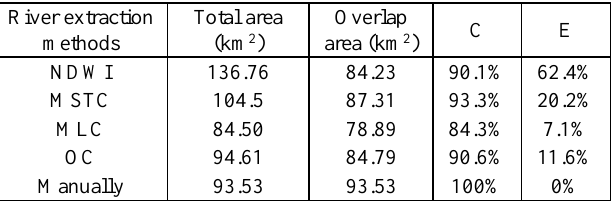
Table 2. Accuracy of different river extraction